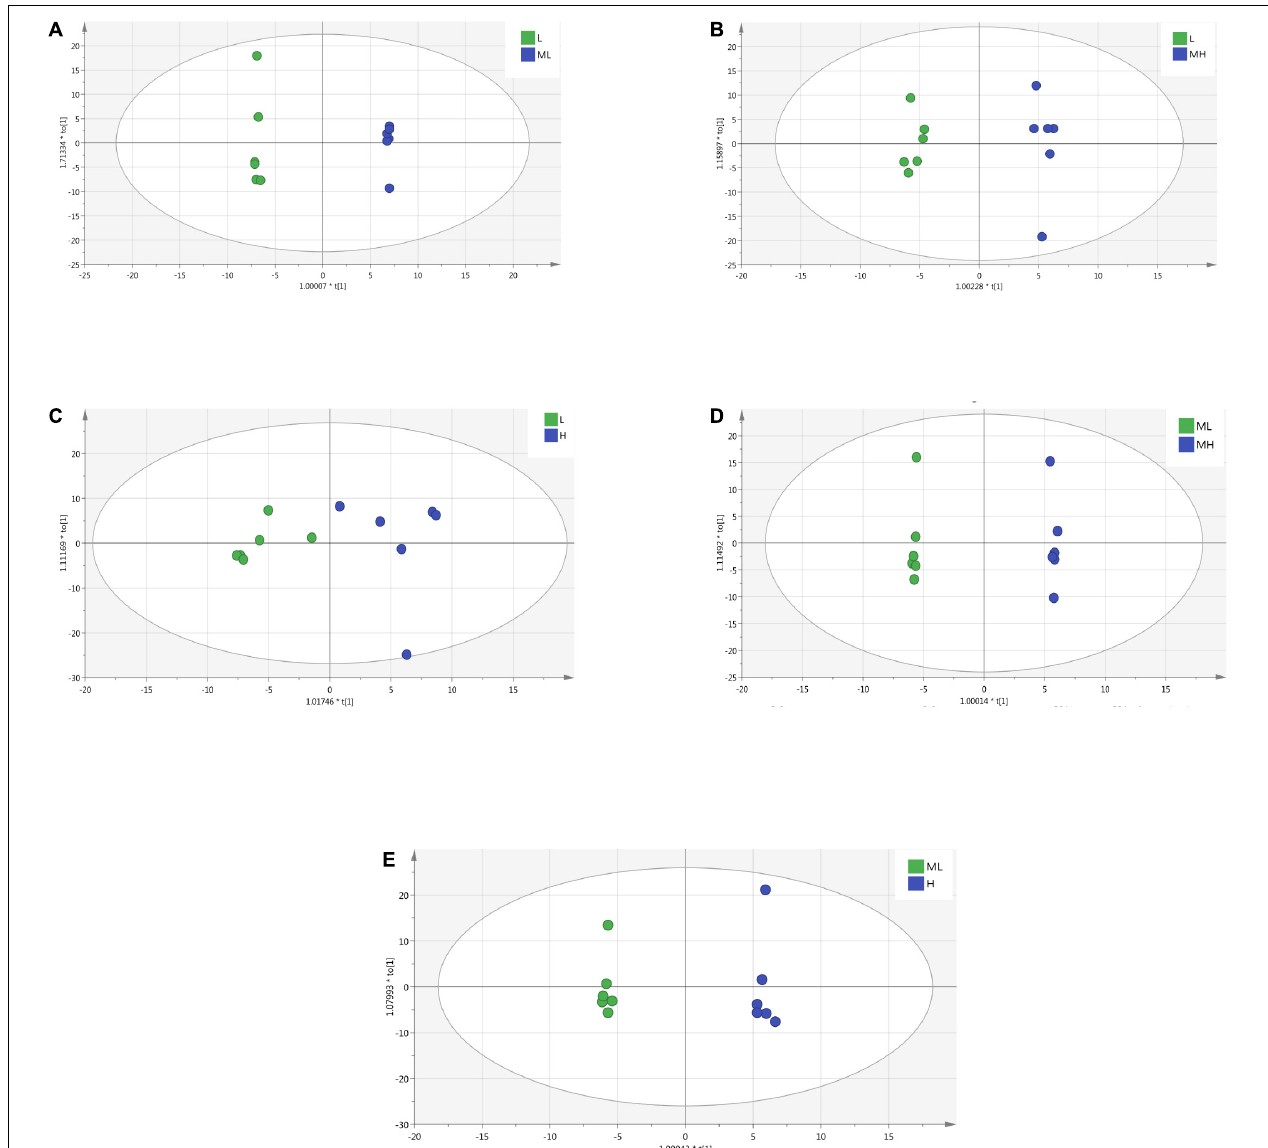
FIGURE 4 | OPLS-DA score plots derived from the GC-TOF/MS metabolite profiles of rumen samples between yak fed diets with different protein levels. (A) The L group vs. ML group; (B) the L group vs. MH group; (C) the L group vs. H group; (D) the ML group vs. MH group; (E) the ML group vs. H